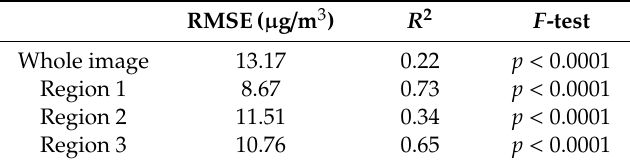
Table 2. The performance indices (with unreliable data